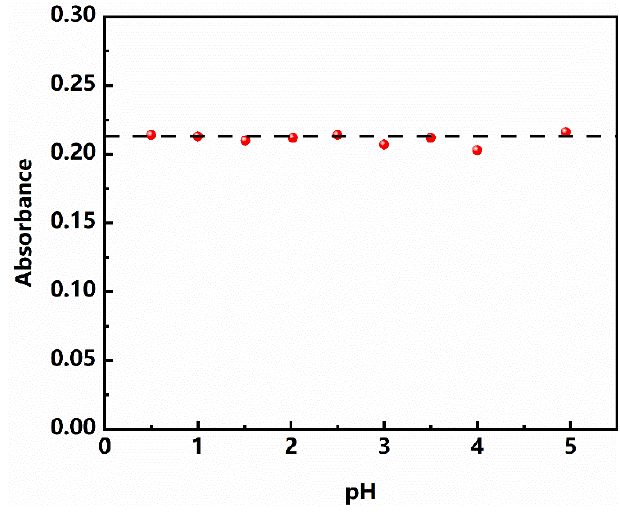
Figure 7. Effect of pH on the absorbance.